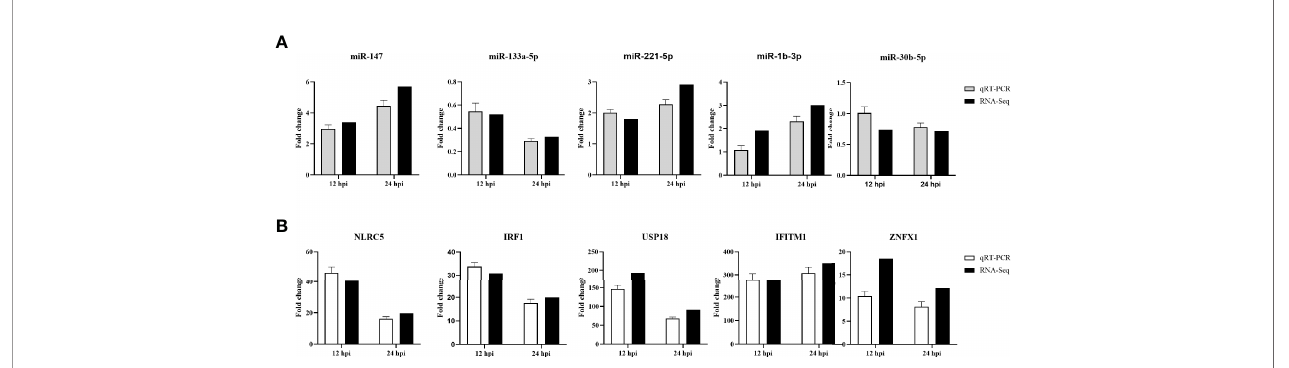
FIGURE 7 | RT-qPCR validation of 5 selected DE miRNAs (A) and 5 DE mRNAs (B) in DHAV-1-infected DEFs at different times. The relative expression level of each miRNA and mRNA in the DHAV-1-infected DEFs were normalized via the comparative 2 − DD CT method and represented as the fold change relative to the mock- infected sample.